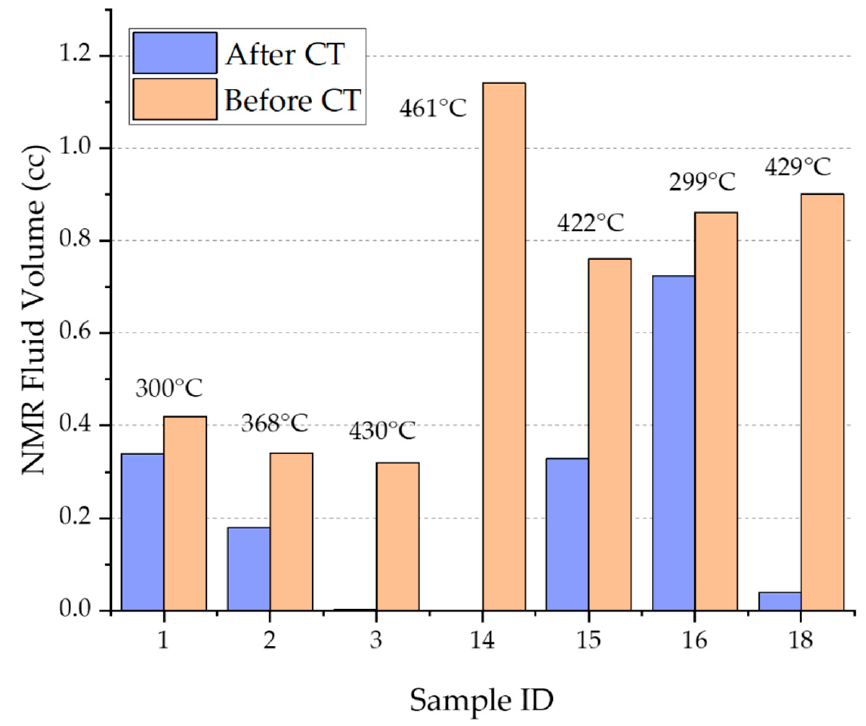
Figure 11. Change in the fluid saturation by NMR after the combustion.